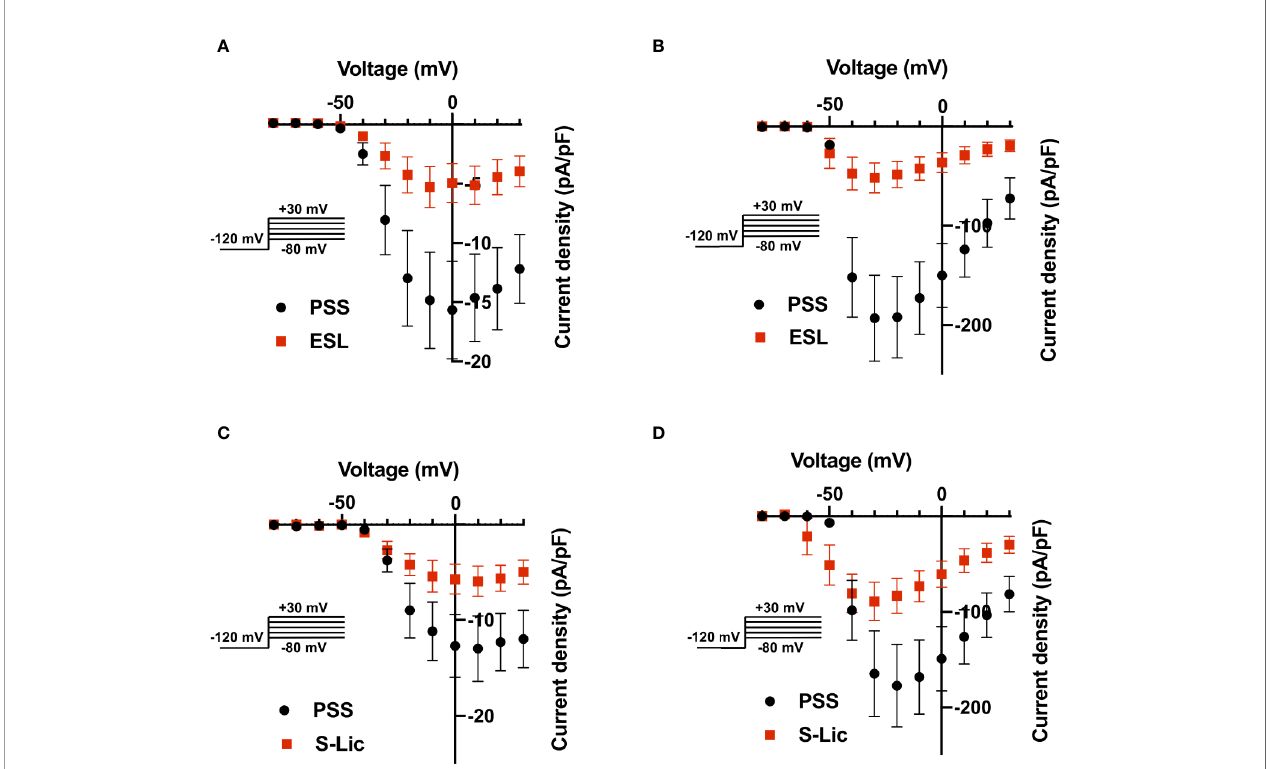
FIGURE 4 | Effect of eslicarbazepine acetate and S-licarbazepine on the current-voltage relationship. (A) Current-voltage (I – V) plots of Na + currents in MDA-MB-231 cells in physiological saline solution (PSS; black circles) and in eslicarbazepine acetate (ESL; 300 m M; red squares). (B) (I – V) plots of Na + currents in HEK-Na v 1.5 cells in PSS (black circles) and ESL (300 m M; red squares). (C) I – V plots of Na + currents in MDA-MB-231 cells in PSS (black circles) and S-licarbazepine (S-Lic; 300 m M; red squares). (D) I – V plots of Na + currents in HEK-Na v 1.5 cells in PSS (black circles) and S-Lic (300 m M; red squares). Currents were elicited using 10 mV depolarising steps from -80 to +30 mV for 30 ms, from a holding potential of -120 mV. Results are mean ± SEM (n = 7 –